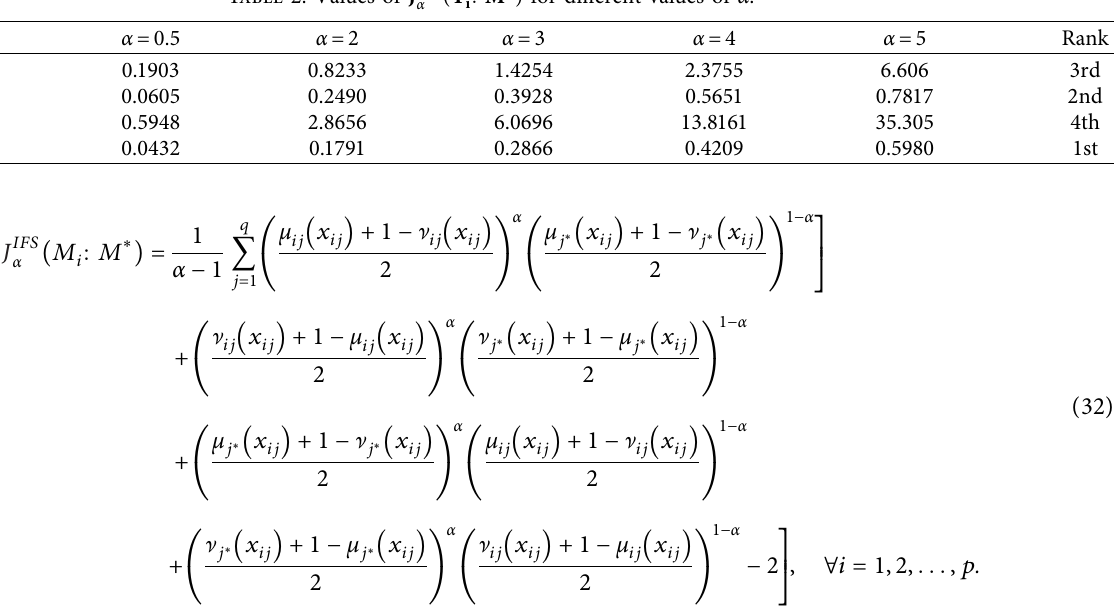
Table 2: Values of J IFS